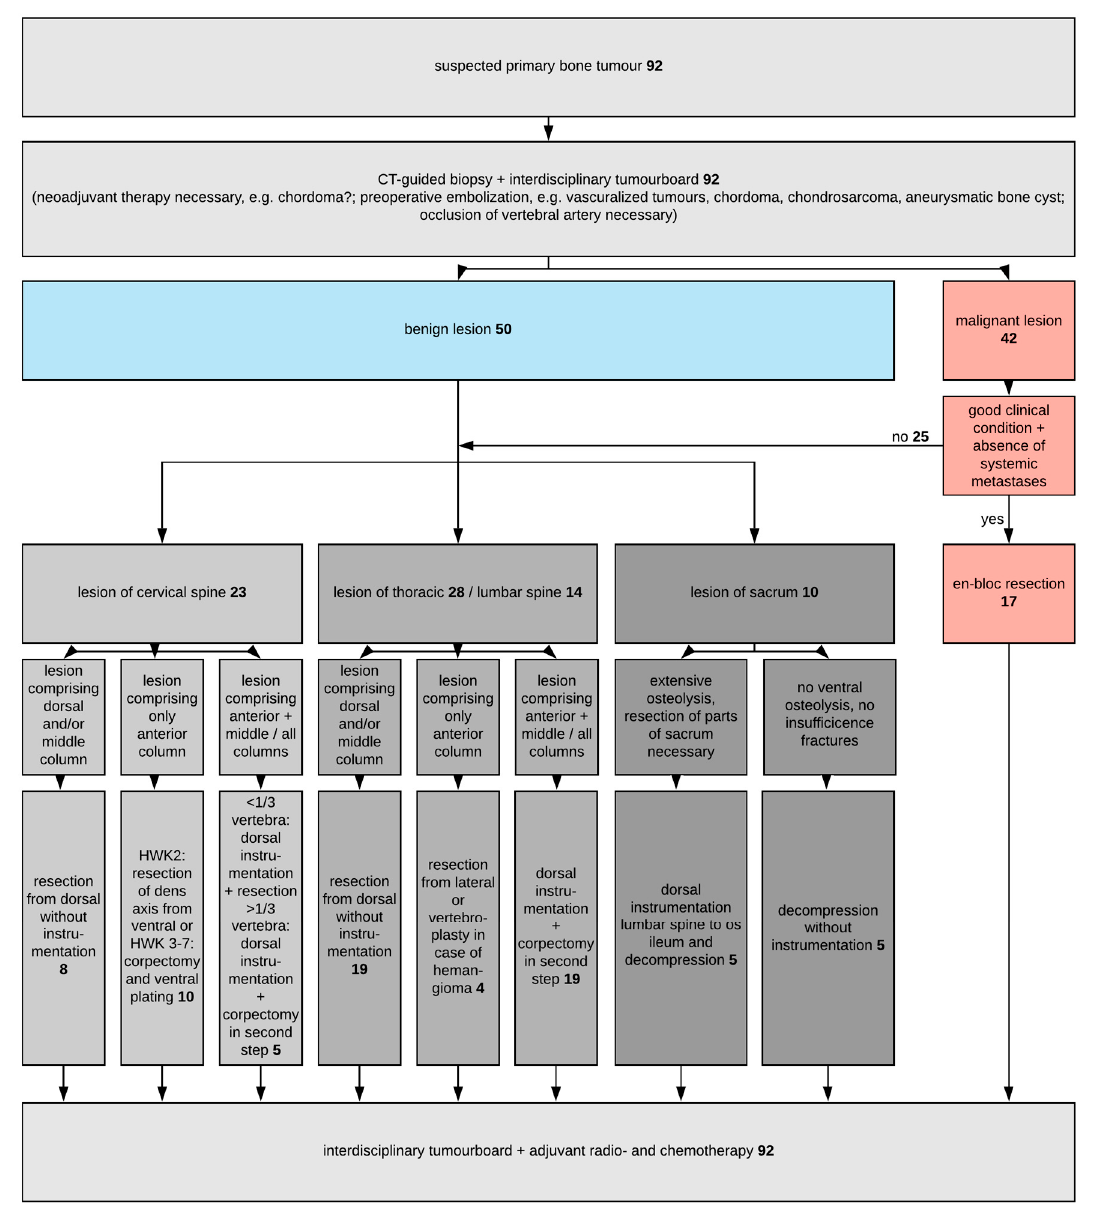
Figure 2. Flow-chart of treatment in case of primary bone tumors.